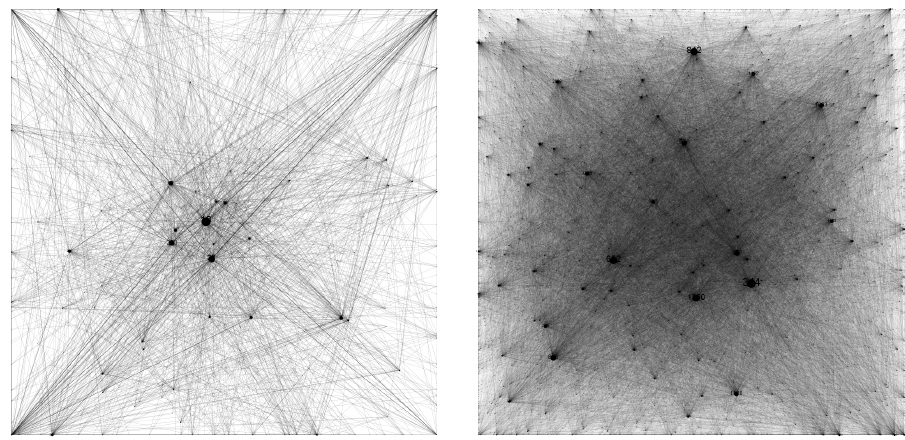
Figure 2. Visual representation of the LN. The plot on the left refers to 2018/02/12, while the one on the right to